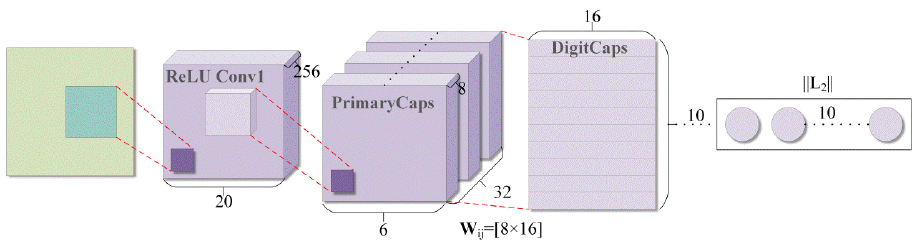
Figure 1. Capsule network with three layers for the classification of MNIST dataset [11].